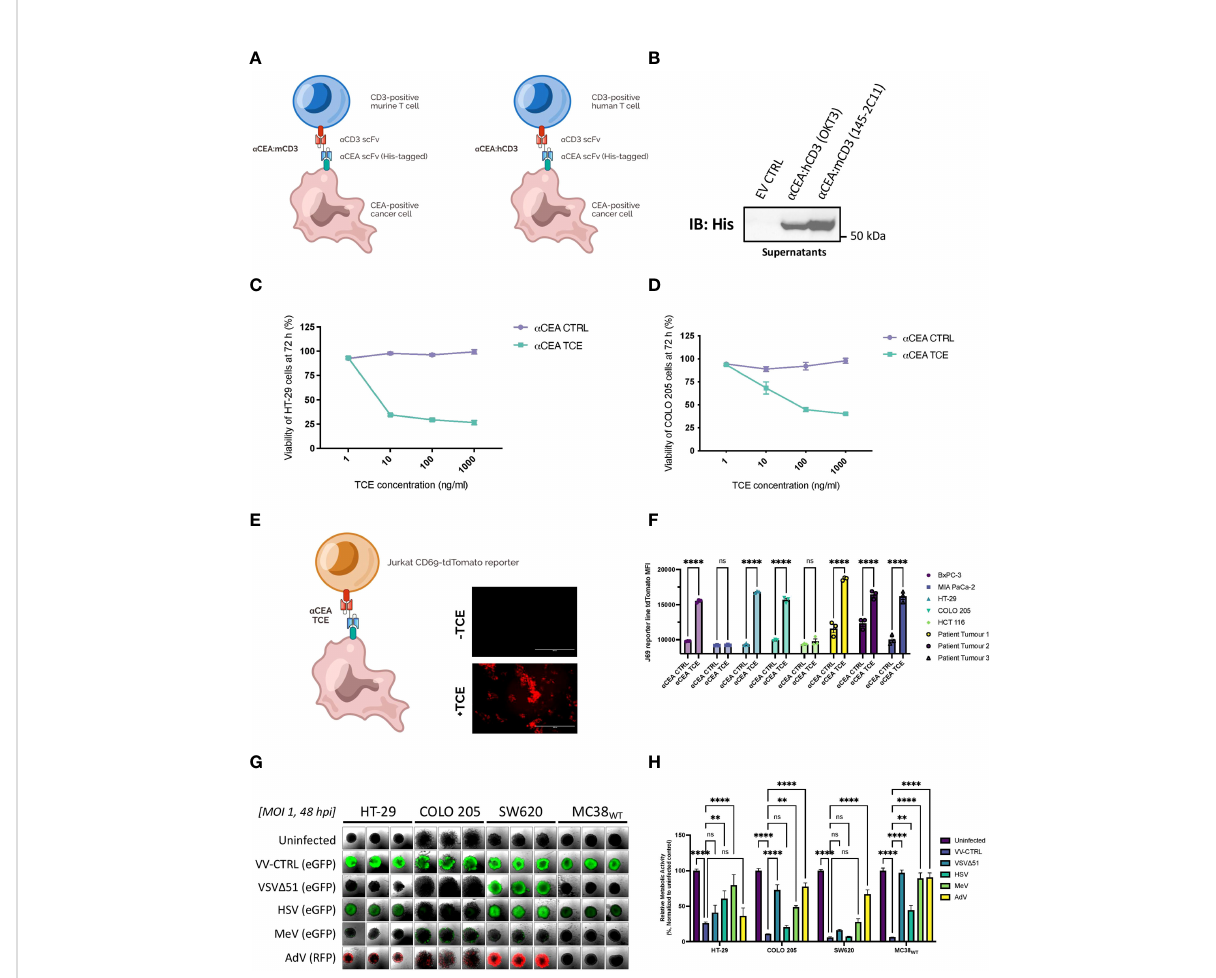
FIGURE 1 Generation and validation of TCEs targeting CRC cells to encode into oncolytic vaccinia virus as an optimal delivery system. (A) Two novel TCEs were designed by linking a scFv that binds human CEA on the surface of cancer cells to a scFv that recognizes CD3 e on either murine T cells ( a CEA:mCD3) or human T cells ( a CEA:hCD3) which can be CD4 or CD8 positive. (B) HEK293T cells were transiently transfected with a CEA TCE constructs or pcDNA3.1 empty vector control (EV) and incubated for 48 h. TCE-containing supernatants were collected, spun down to remove cell debris, and concentrated using centrifugal fi lter units with a 10 kDa molecular weight cutoff. Samples were quanti fi ed by BCA assay to load 10 µg of supernatant per lane, separated by SDS-PAGE, and immunoblots were probed with a His antibody to detect His-tagged TCEs. No His tag was detected for the EV control as expected. (C) HT-29 cells were co-cultured with human PBMCs (E:T = 5:1) and a CEA TCE ( a CEA:hCD3) or a CEA CTRL ( a CEA:mCD3) at indicated concentrations. Resazurin assay was performed at 72 h to determine cancer cell viability after TCE treatment. Results show relative % ± SEM. (D) COLO 205 cells were co-cultured with human PBMCs (E:T = 5:1) and a CEA TCE ( a CEA:hCD3) or a CEA CTRL ( a CEA:mCD3) at indicated concentrations. Resazurin assay was performed at 72 h to determine cancer cell viability after TCE treatment. Results show relative % ± SEM. (E) In co-cultures with HT-29 cells that express CEA and Jurkat CD69-tdTomato reporter cells (J69; T cells were modi fi ed by CRISPR to express tdTomato under the control of the CD69 promoter), the addition of TCEs (1 µg) leads to the visualization of tdTomato-positive Jurkat J69 cells (E:T = 1:1). Scale bar = 400 µm. (F) Three patient-derived CEA-positive colorectal cancer cell lines and other CEA-positive cells (BxPC-3, HT-29, COLO 205) activate J69 cells in co-cultures with a CEA TCE ( a CEA:hCD3), but not with a CEA CTRL ( a CEA:mCD3) or CEA-negative control cell lines (MIA PaCa-2, HCT 116). Results show MFI ± standard error of the mean (SEM); Two-way ANOVA with Sidak ’ s correction for multiple comparisons. (G) HT-29, COLO 205, SW620 and MC38 WT spheroids were infected at an MOI 1 of oncolytic vaccinia virus (Copenhagen/Cop strain) VV-CTRL, oncolytic Vesicular Stomatitis virus (VSV D 51), oncolytic Herpes simplex virus (HSV), oncolytic Measles virus (MeV), or oncolytic Adenovirus (AdV). Spheroids were imaged at 48 hpi to detect transgene expression of enhanced green fl uorescent protein (eGFP) or red fl uorescent protein (RFP). All colorectal cancer spheroids expressed abundant eGFP levels after VV-CTRL infection, compared to other viruses. (H) Spheroid viability was assessed in triplicate by resazurin assay at 120 hpi, relative to uninfected controls. VV-CTRL decreased cell viability of HT-29, COLO205, SW620 and MC38 WT spheroids. vaccinia virus was able to infect all the colorectal cancer cell lines as spheroids. VV-CTRL decreased cell viability of HT-29, COLO205, SW620 and MC38 WT spheroids. Other viruses also decreased spheroid viability to a lesser extent. Of note, MeV did not signi fi cantly change the viability of MC38 WT spheroids, as expected, since this oncolytic virus do not infect murine cancer cell lines but served as a control. Results show relative % ± SEM; Two-way